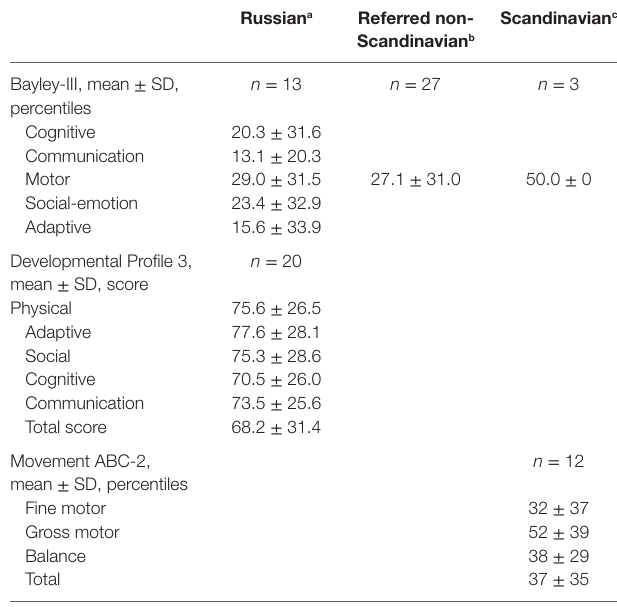
TaBle 4 | Bayley-III, Developmental Profile 3 and Movement ABC-2 test results for children with congenital